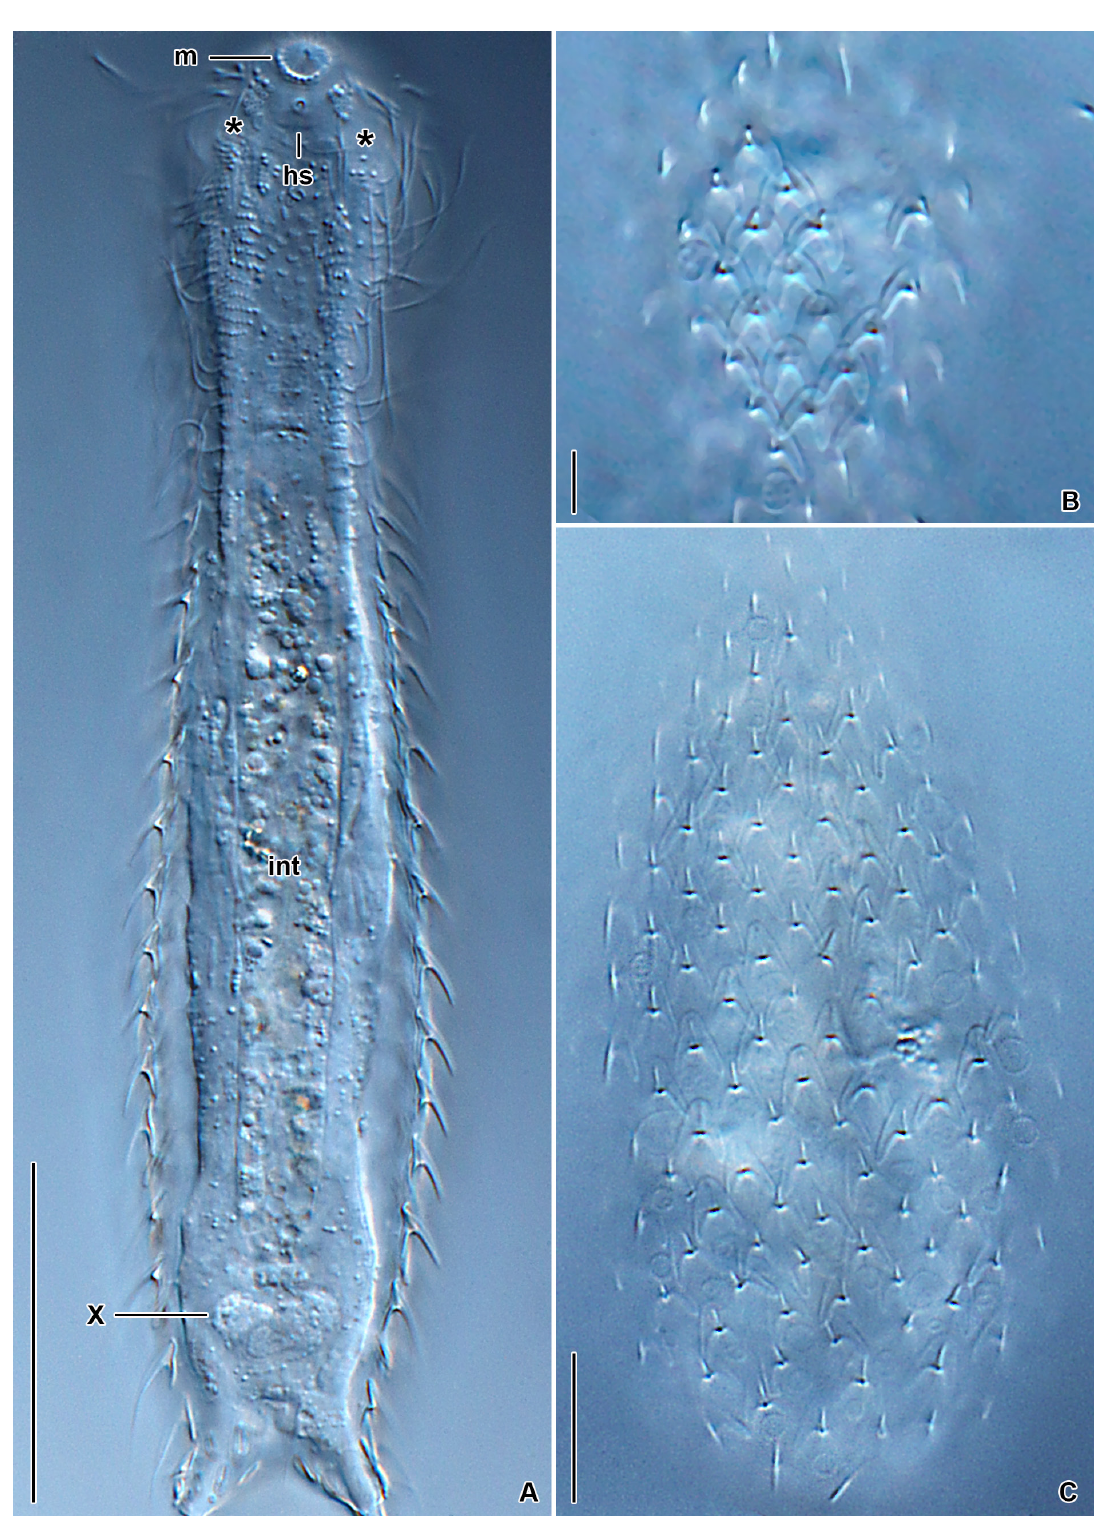
Fig. 20. Chaetonotus ( Hystricochaetonotus ) optabilis sp. nov., differential interference contrast. A . Paratype (CU-FNS-05-03-20-3/PA-2). B–C . Holotype (CU-FNS-05-03-20-1/HO). A . Overview showing the general body organization. Asterisks mark the beginning of the ventral ciliary bands. B‒C . Surface views, showing the head and trunk scale patterns. Scale bars: A = 30 µm; B = 5 µm; C = 10